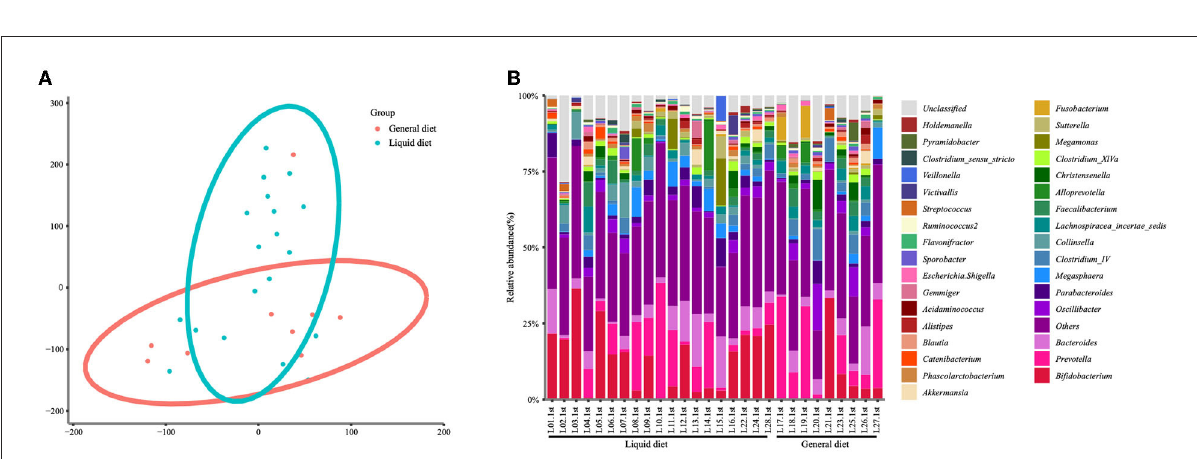
FIGURE4 Changes in gut microbiota at the genus level in the children of the general diet group and liquid diet group. The clustering diagram of the two groups (A) and the stacked bars of the top 30 abundant genera of each participant are shown (B)